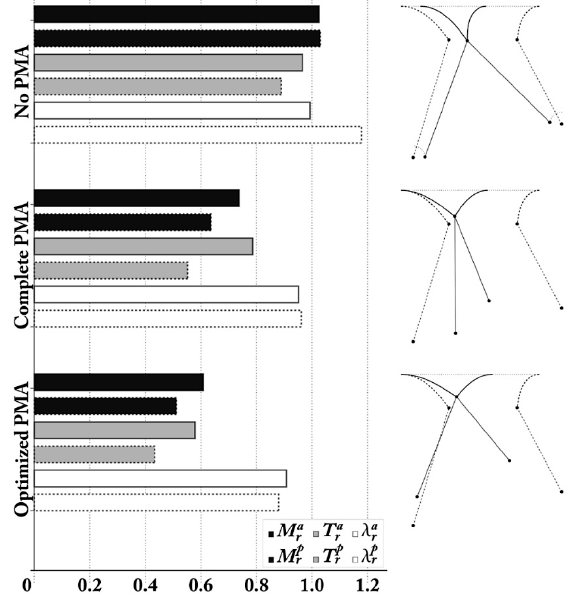
Figure 8. Comparison of the optimized postoperative outcome with both absent PMA and complete PMA. Different outcomes were obtained by starting from the same pre-operative configuration. In each case, effectiveness of the outcomes was measured by means of non-dimensional indicators in terms of i) valvular annulus stress ratio (black bars), measured as the ratio between post-operative and pre-operative bending moments predicted in the leaflets roots M i r = M i po / M i pre . ii ) Chordae stress ratios T i r = T i po / T i pre , evaluated as the ratio between the post-operative and the pre-operative nominal axial stresses of the chordae tendinae (Gray bars). iii ) Stretch ratios of the chordae tendinae λ i r = λ i po / λ i pre (white bars), denoting the ratio between post-operative and pre-operative lengths of the chordae. Bars with dashed contours refer to posterior leaflets.